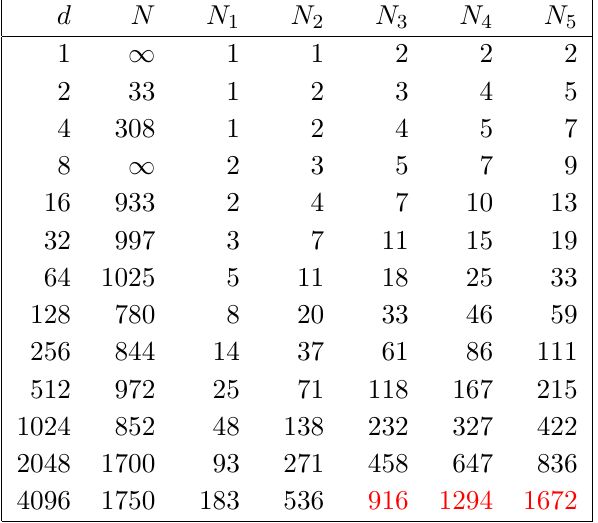
density ) /d to within 0 . 5 · 10 − k , 2